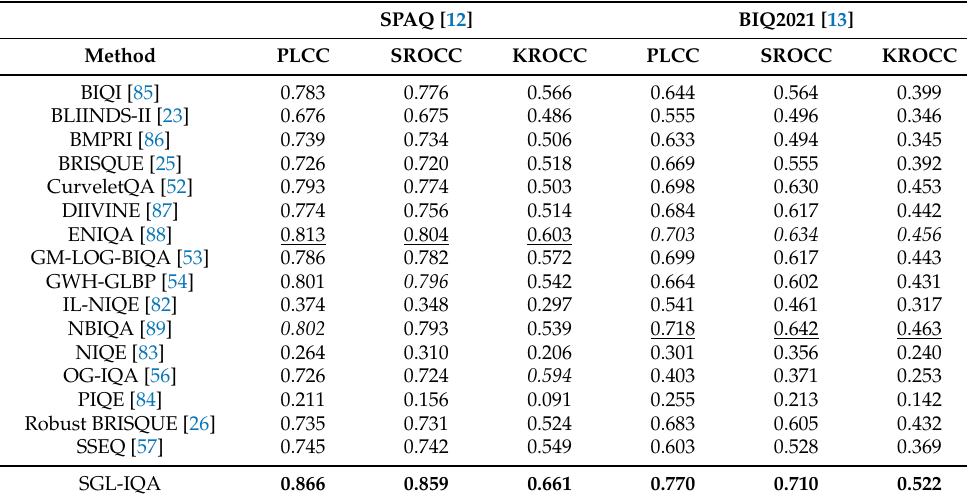
Table 4. Comparison to other state-of-the-art algorithms using SPAQ [12] and BIQ2021 [13] databases. Median PLCC, SROCC, and KROCC values were measured over 100 random train-test splits. The best results are given in bold, the second-best results are underlined, and the third-best results are given in italics.